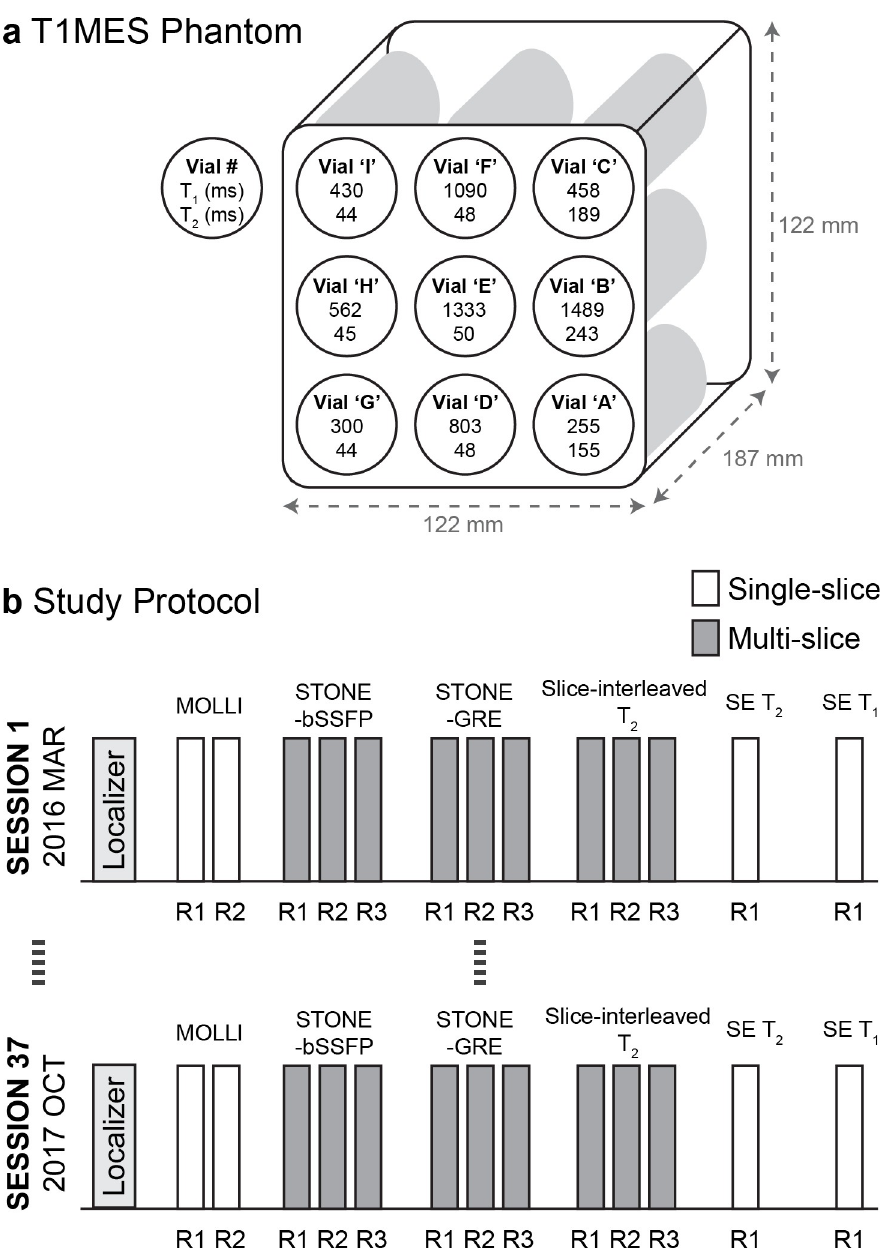
Fig 1. T1MES phantom used in this study, and the reproducibility study protocol. a) The T1MES phantom used in this study consists of 9 vials of NiCl 2 doped agarose covering T 1 and T 2 ranges in the blood and myocardium before and after Gadolinium-based contrast agents. b) An imaging session was repeated every 2–3 weeks over 20 months (between-session reproducibility). Within each session, slice-interleaved T 1 and T 2 mapping sequences were repeated 3 times (between-repetition repeatability) for five slices (between-slice repeatability). SE T 1 and T 2 measurements and MOLLI were performed for comparison. STONE-bSSFP, slice-interleaved T 1 with balanced steady-state free precession; STONE-GRE, slice-interleaved T 1 with spoiled gradient echo; SE, spin-echo. [30], STONE-GRE T mapping [31], and slice-interleaved T mapping [32] sequences. Within 1 2 each session, imaging was repeated 3 times to allow repeatability assessment within each ses- sion and between repetitions. For multi-slice sequences, between-slice repeatability was also